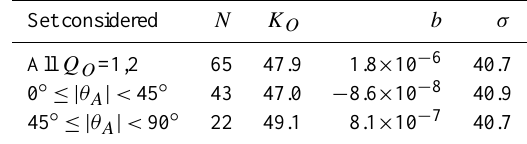
Table A1. Coefficients for Eq. (A1) a